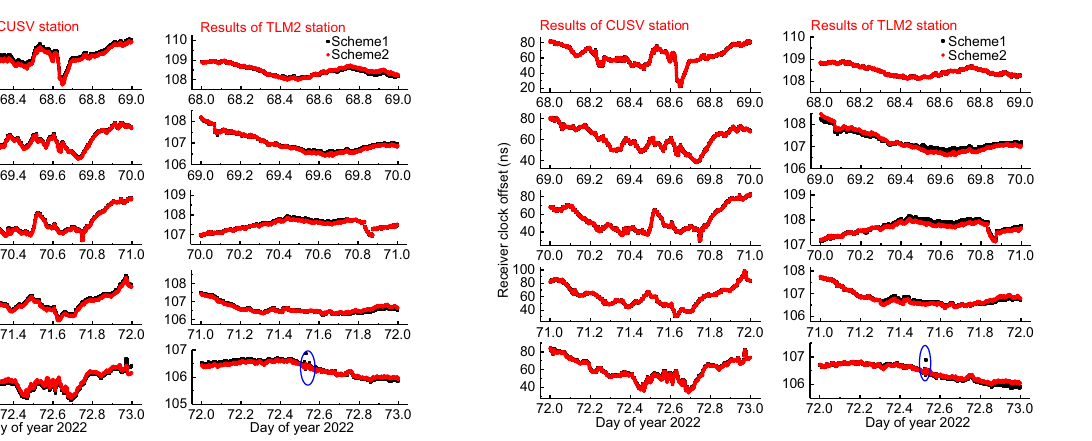
Fig. 8 CUSV and TLM2 receiver clock offsets from BDS-3 PPP in Scheme 1 and Scheme 2